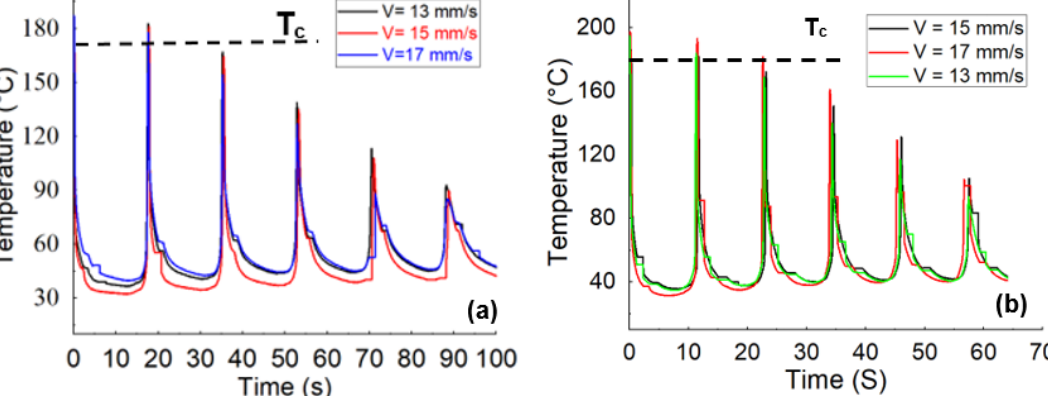
Figure 3. The obtained temperature evolution from the in situ temperature monitoring ( a ) PA6 and ( b ) CF-PA6 [5] under different print speeds .